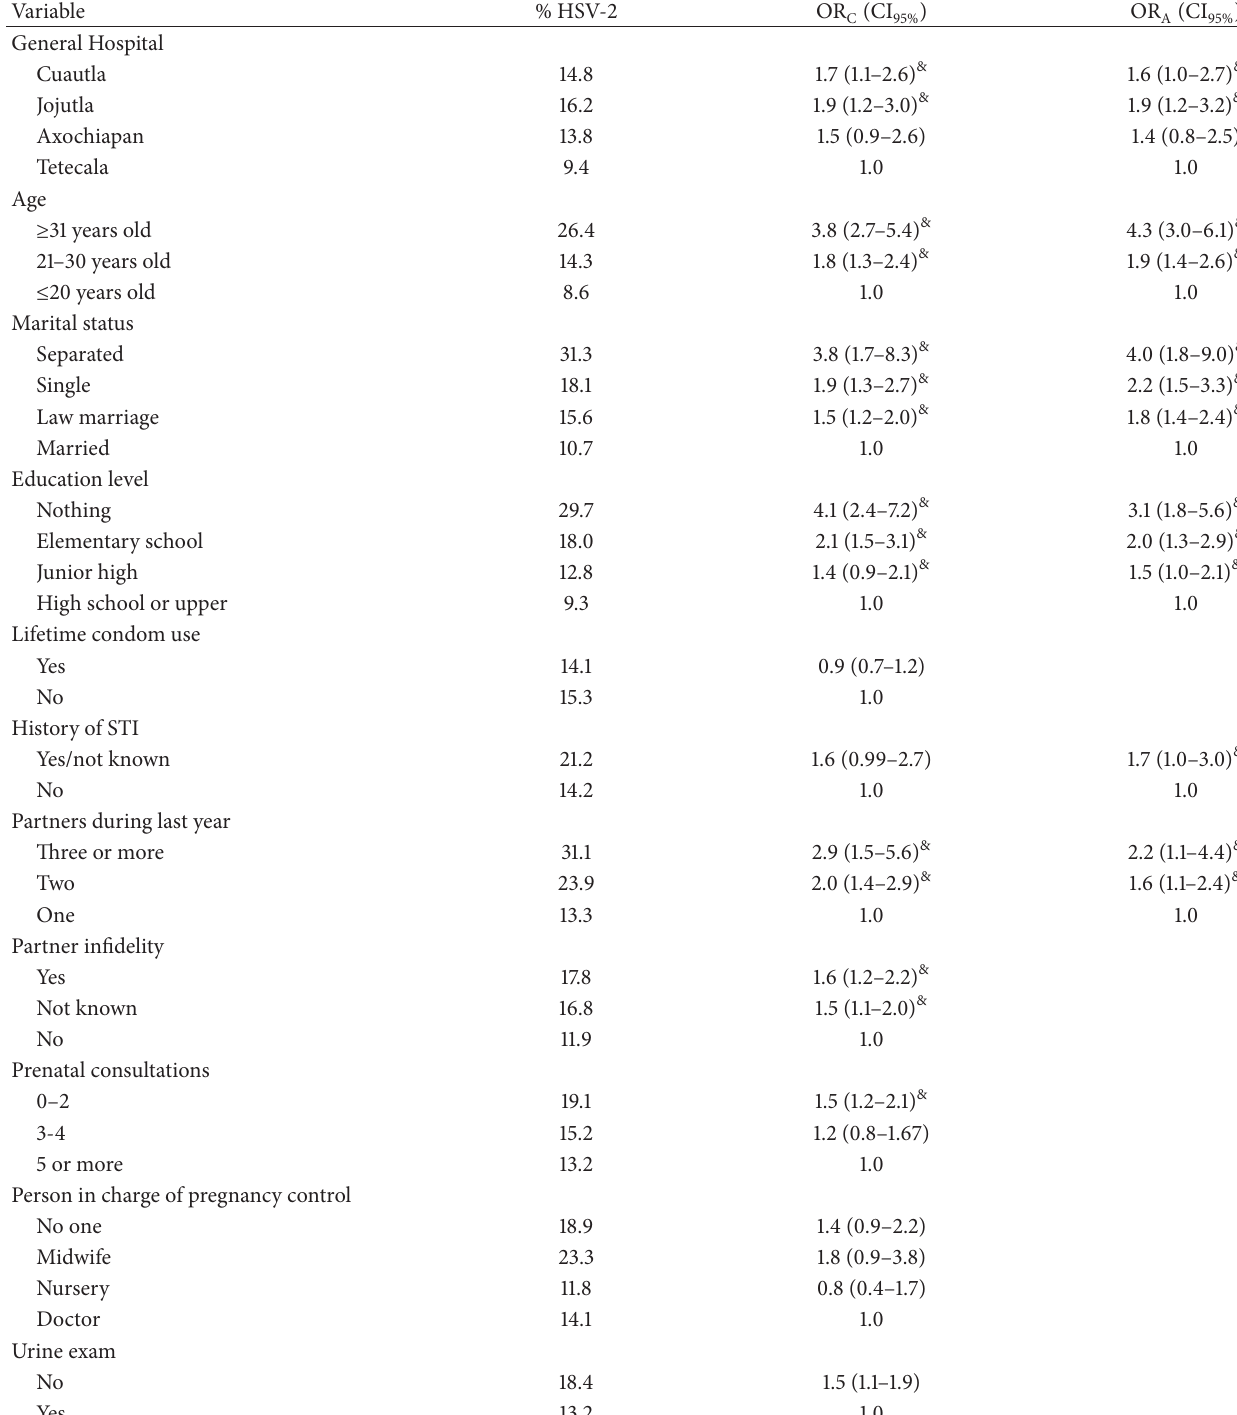
Table 2: HSV-2 seroprevalence and risk factors among puerperal and pregnant women from Morelos,